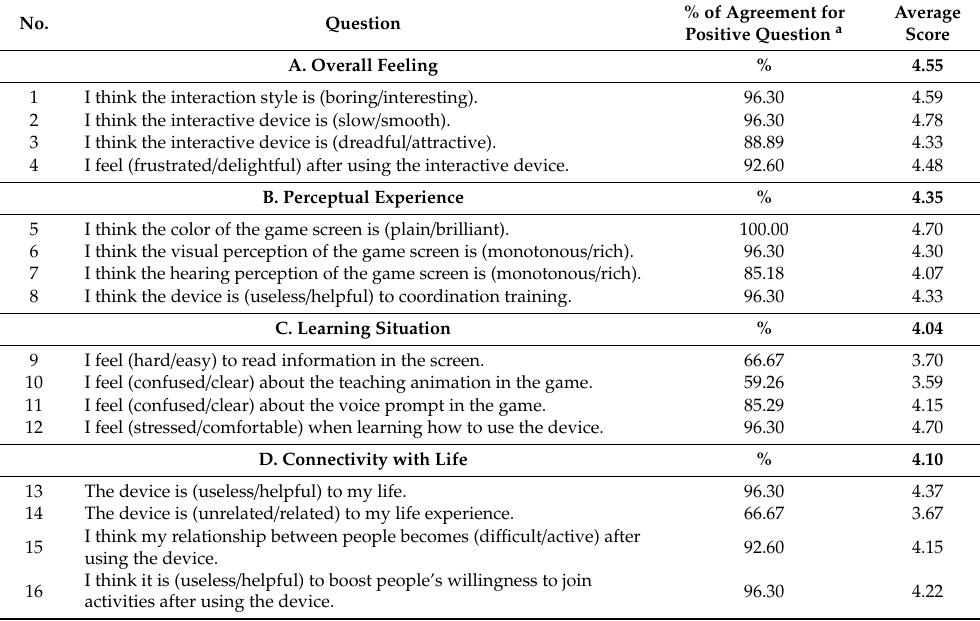
Table 5. Questions about user interaction satisfaction usability in the questionnaire and statistics of percentages and averages of the scores of the answers to the